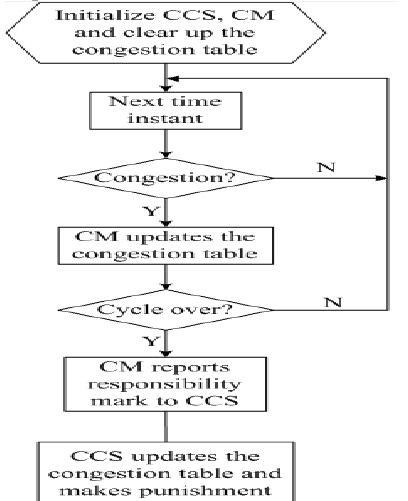
Fig. 9. The flowchart of congestion controller and congestion control server.